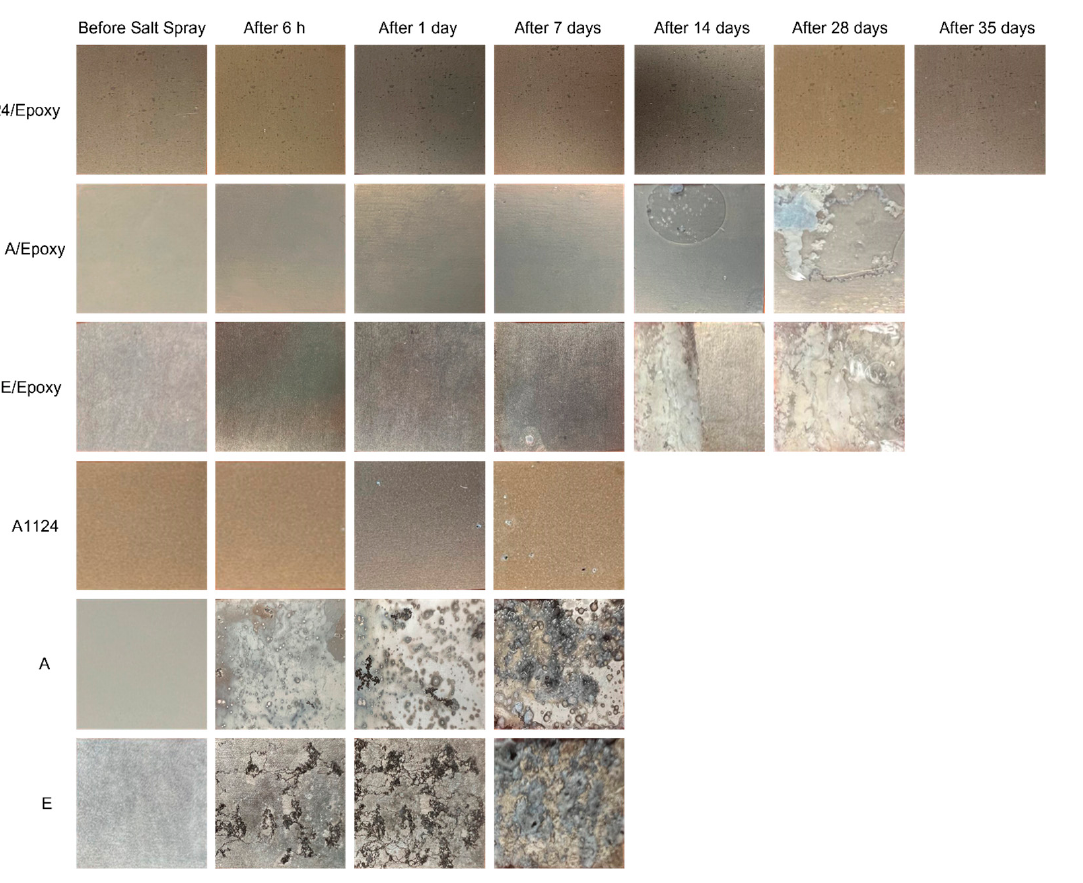
Figure 16. Macroscopic images of the x-cut samples after salt spray test.